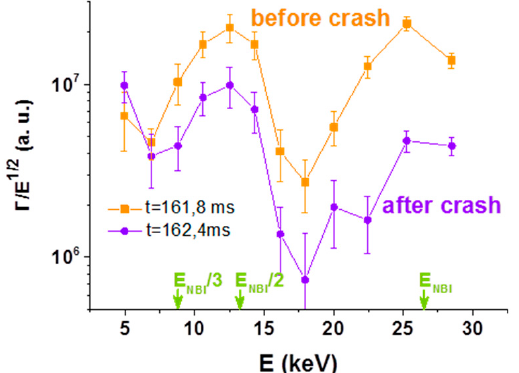
Figure 14. Fast CX atom spectra in discharge #31965 with sawtooth oscillations: squares—before reconnection; circles—after reconnection. The figure is taken from [45] and reproduced with permission from IOP Publishing.